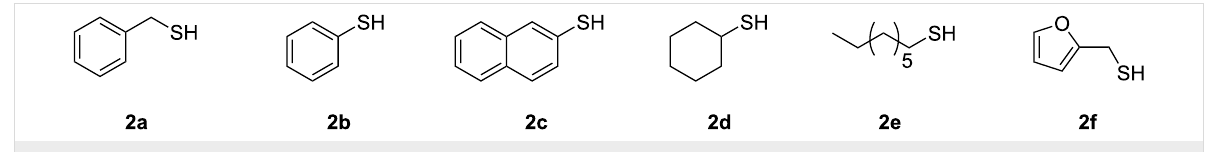
Figure 2: Structures of thiols 2a–f used in the present